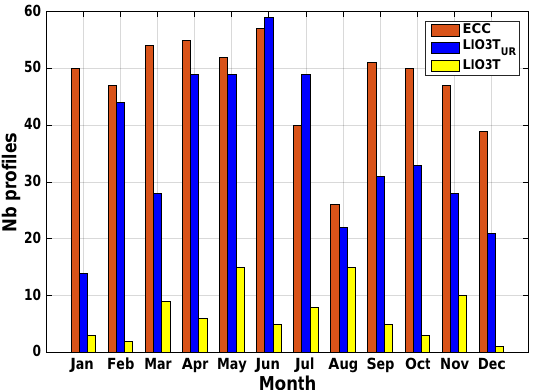
Figure 10. Number of O 3 profiles per month for ECC (1998–2015, 568 profiles), LIO3T UR (1998–2010, 427 profiles) and LIO3T